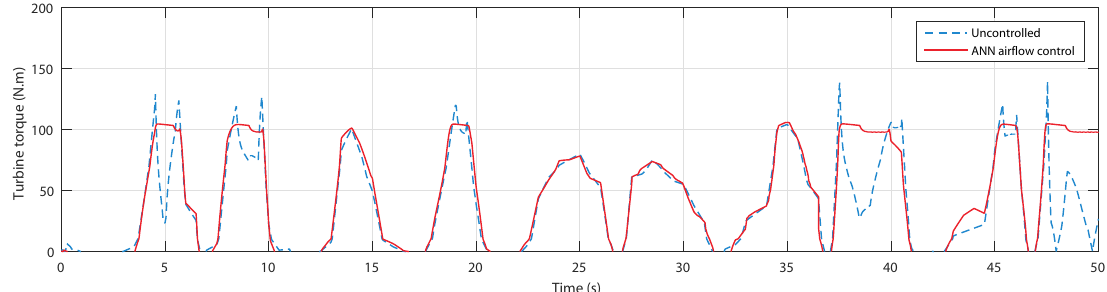
Figure 22. Turbine torque for uncontrolled case and ANN-based airflow control. Same as the torques, the generated powers have successfully avoided the stalling effect, as indicated in Figure 23.